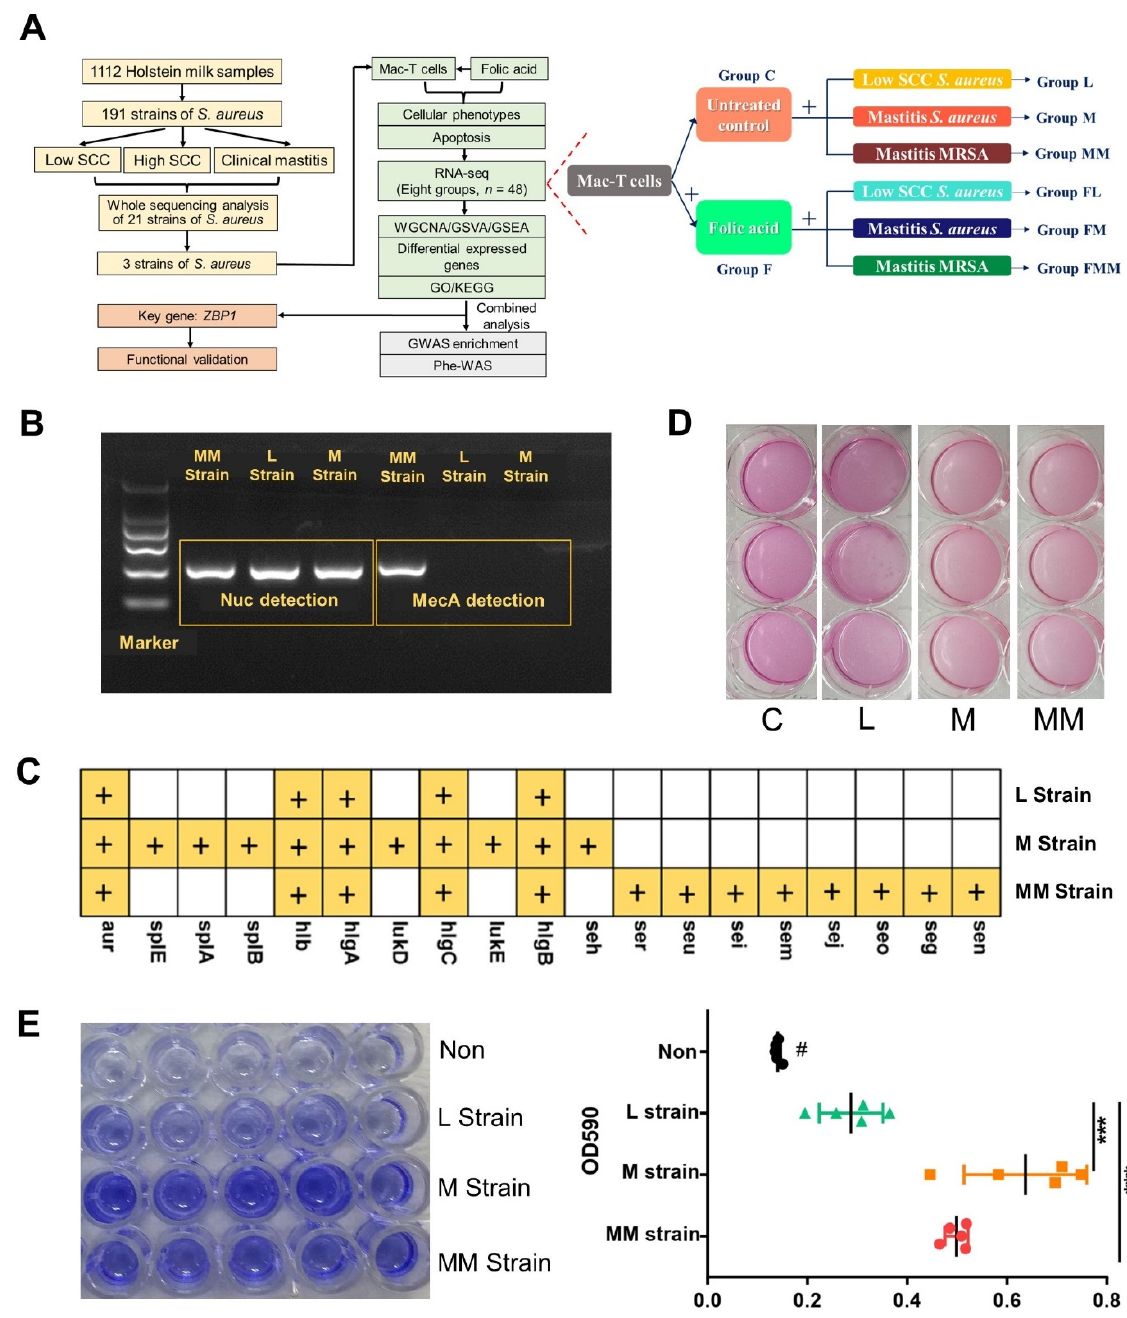
Figure 1. Experimental design and characteristics of three S. aureus strains. ( A ) Overview of experimental design. Eight groups of Mac-T cells include Group C: untreated control; Group L: treated with L strain of S. aureus ; Group M: treated with M strain of S. aureus ; Group MM: treated with MM strain of MRSA; Group F: treated with folic acid; Group FL: folic acid treatment plus L treatment; Group FM: folic acid treatment plus M treatment; Group FMM: folic acid treatment plus MM treatment. The colors for the groups are the same in all figures. ( B ) Detection of S. aureus /MRSA by nuc - and mecA -specific PCR. L strain: S. aureus strain from cattle with low SCC; M strain: S. aureus strain from mastitis cattle; MM strain: MRSA strain from mastitis cattle. ( C ) Virulence factors genes of the three S. aureus strains identified by re-sequencing. ( D ) Cytotoxicity of these three S. aureus strains to cells. Darker red media indicates a low number of dead cells, while lighter red media indicates high number of dead cells. The MOI is 50:1. ( E ) Biofilm-forming ability of the three S. aureus strains tested by crystal violet solution. In the left panel, darker blue media indicates strong biofilm forming ability, while lighter blue media indicates weak biofilm formation ability. “Non” represents no bacteria added to the negative group. In the right panel, the OD value at 590 nm for different groups (*** p < 0.001). “#” means that the p < 0.001 compared with the other 3